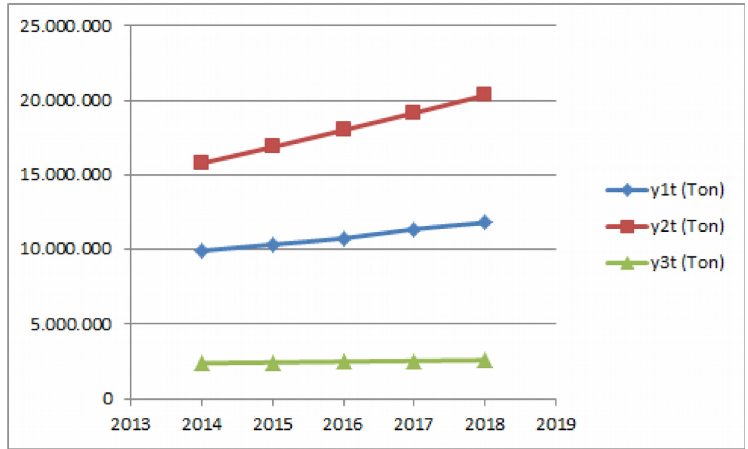
Figure 10. Proportion of SH(y1t), PC(y2t), and SC(y3t) on CPO